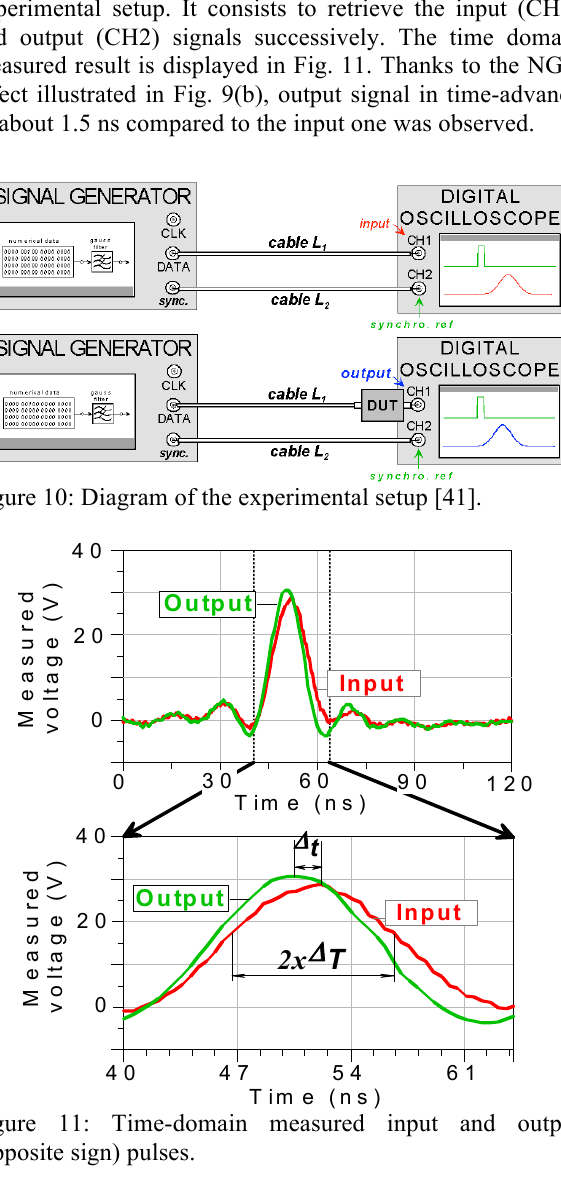
Figure 11: Time-domain measured input and output (opposite sign) pulses.